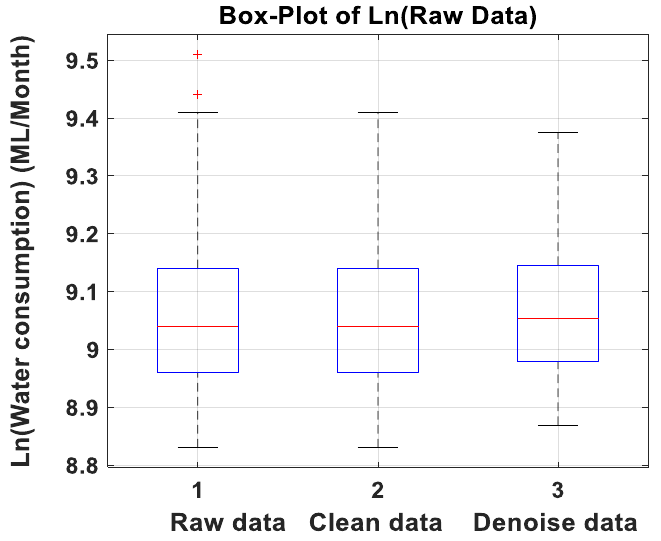
Figure 5. The box plot distribution for raw, clean, and denoise data.